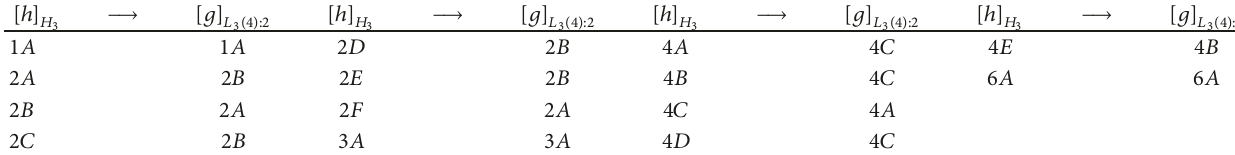
Table 4: The fusion of 𝐻 3 into 𝐿 3 (4) : 2